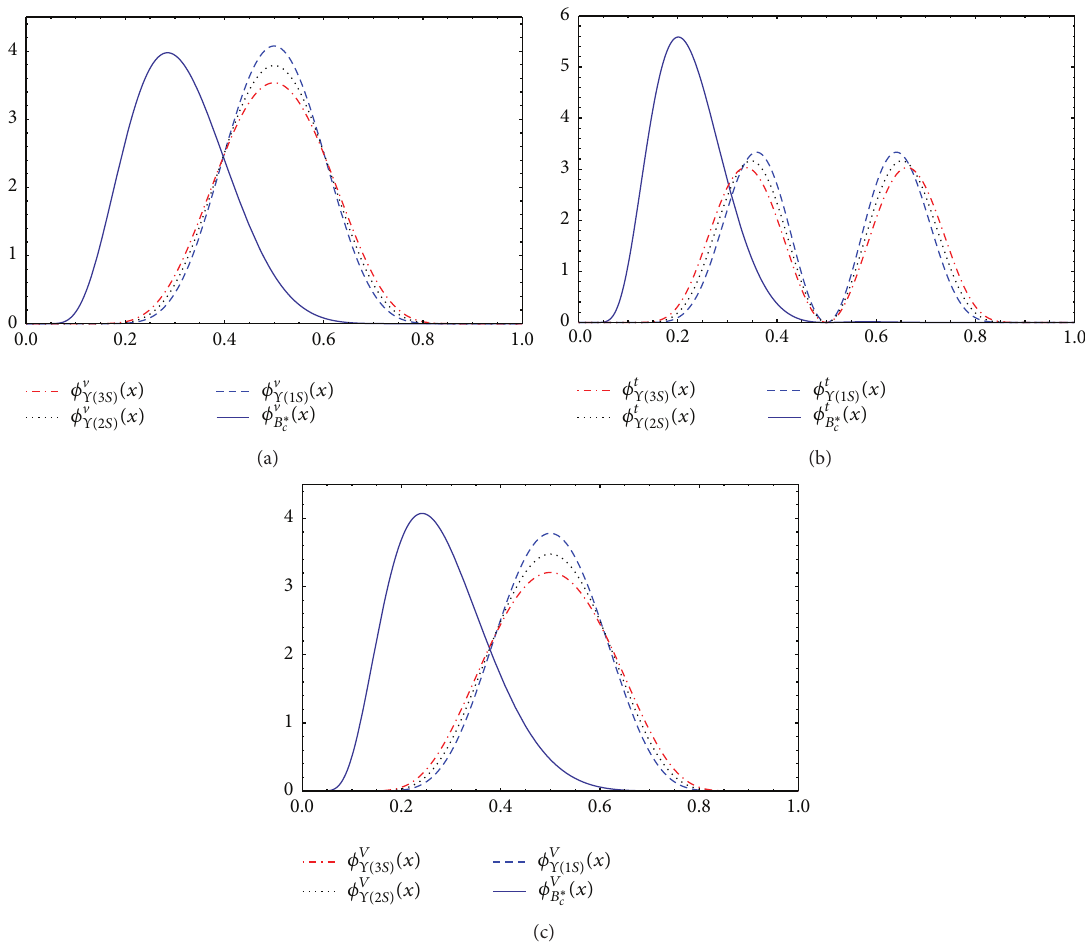
Figure 1: The normalized distribution amplitudes for Υ(𝑛𝑆) and 𝐵 ∗ 𝑐 mesons.